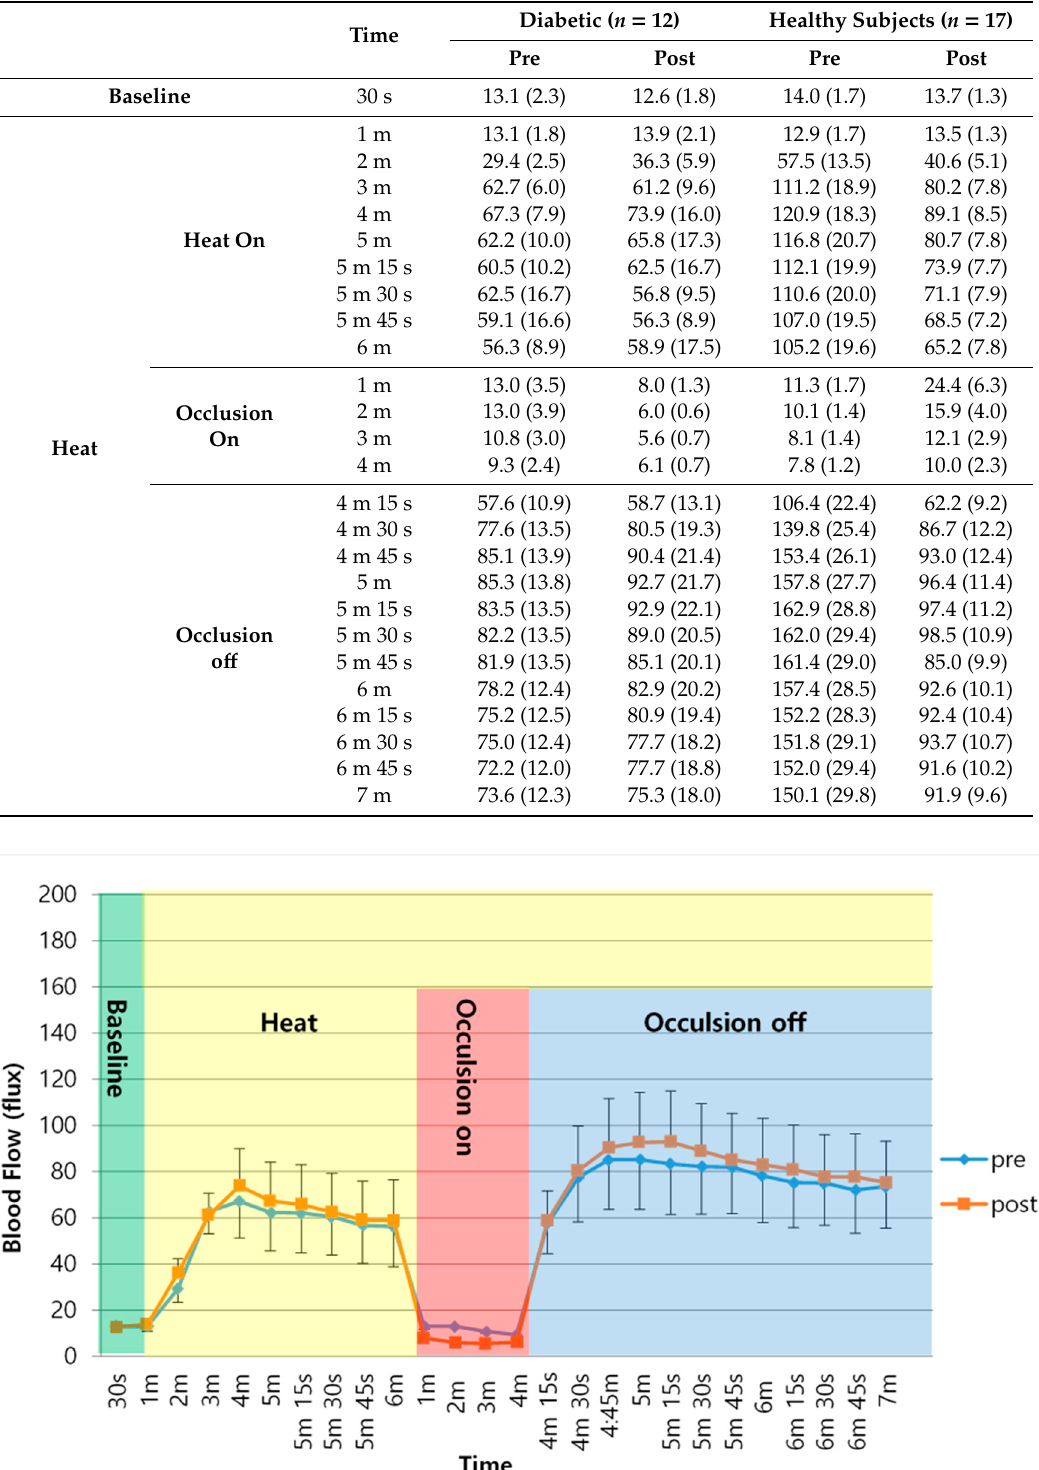
Table 3. Mean (SD) of skin blood flow at pre- and post-intervention over the time in diabetes ( n = 12) and healthy subjects ( n = 17).